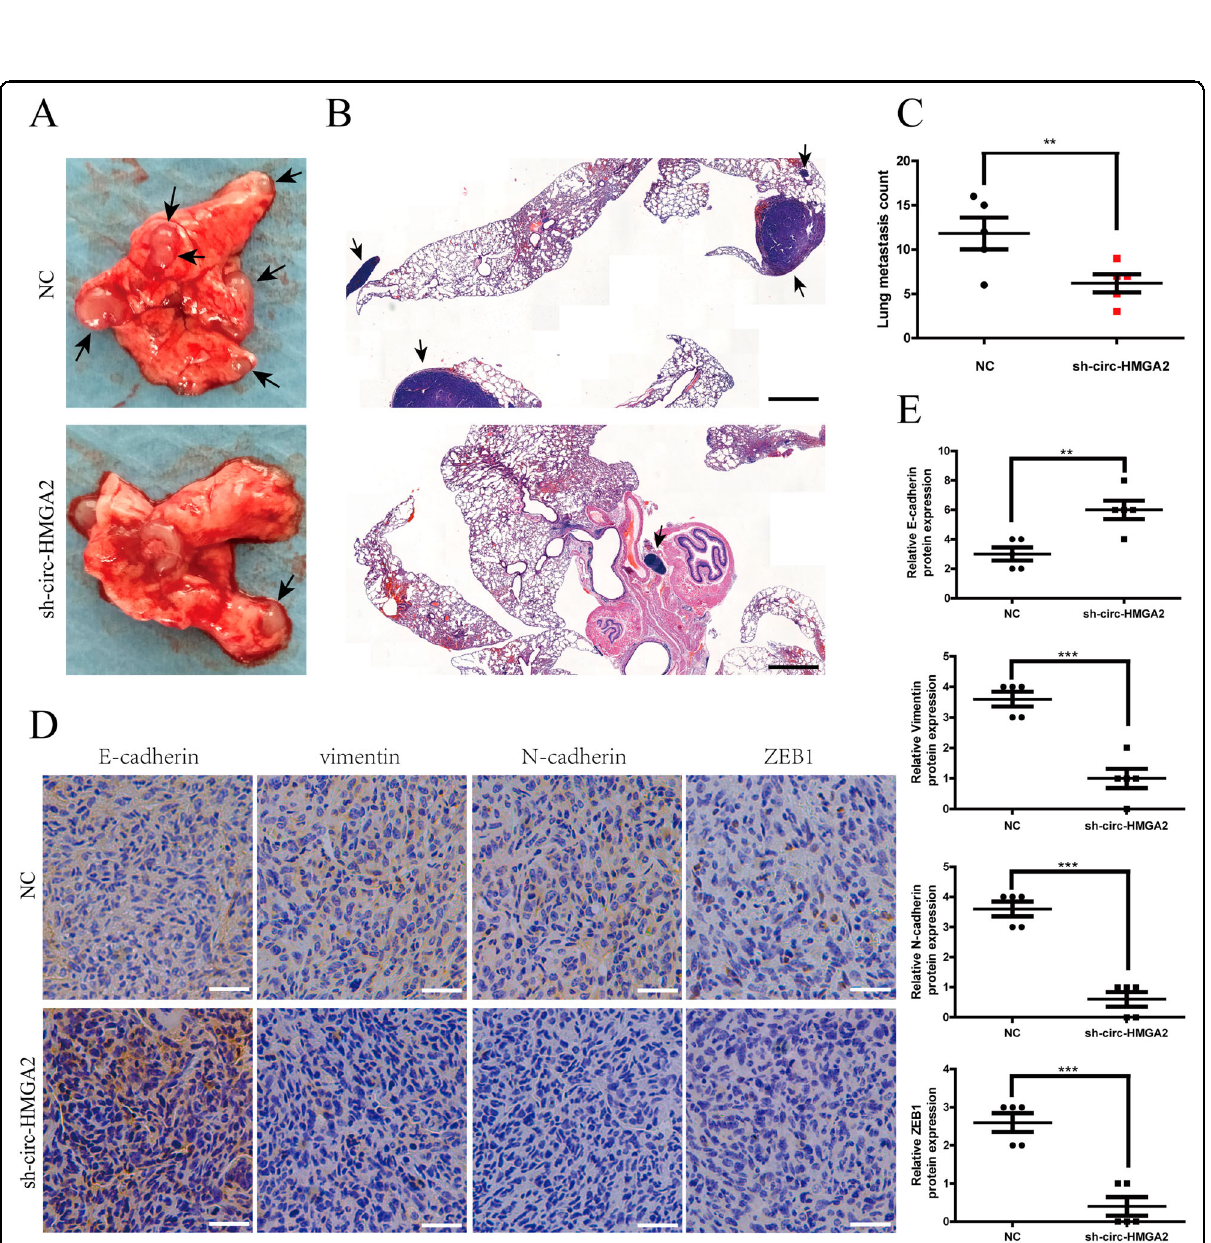
Fig. 4 Circ ‐ HMGA2 promotes the metastasis of LUAD cells in vivo. A In the lung metastasis model, knocking down the expression of circ-HMGA2 resulted in a signi fi cant reduction in the number of metastases on the lung surface. B , C HE staining showed that mice in the circ-HMGA2 knockdown group showed signi fi cantly fewer metastases. Scale bar: 500 μ m. D , E The results of IHC showed that knocking down the expression of circ-HMGA2 also inhibited the progress of EMT in vivo. Scale bar: 30 μ m. ** P <